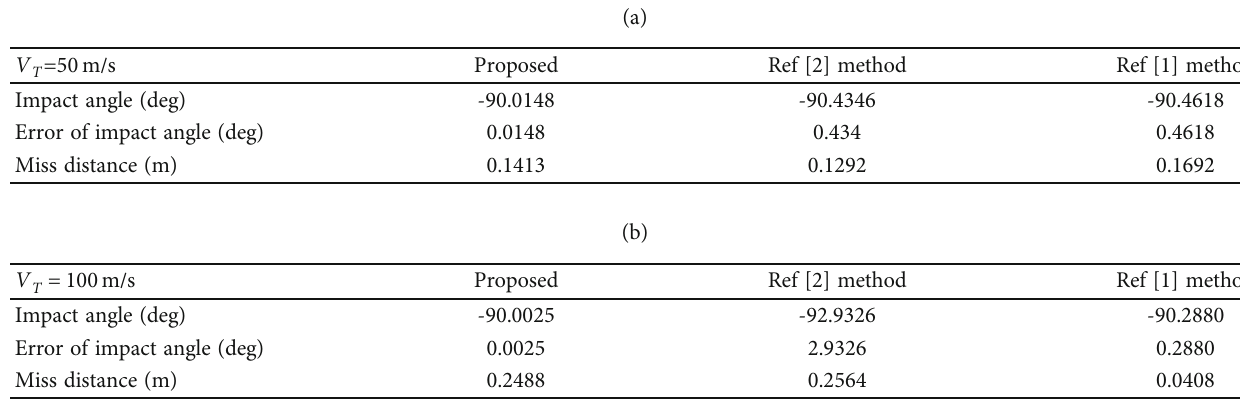
of autopilot is gained. The actual engagement is shown in inated, the above guidance method based on virtual target is Figure 6, V valid. To eliminate the error, the PID controller is a suitable does not point to the virtual target, and σ is M choice. the angle of line MP . If the error between γ and σ is elim- M